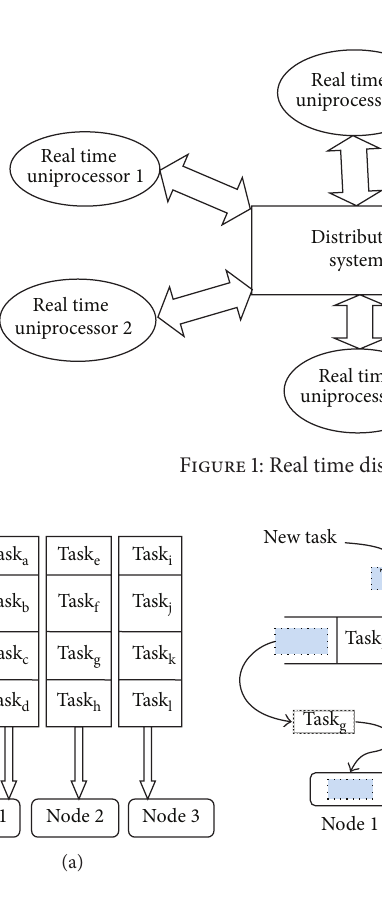
Figure 2: Distributed system